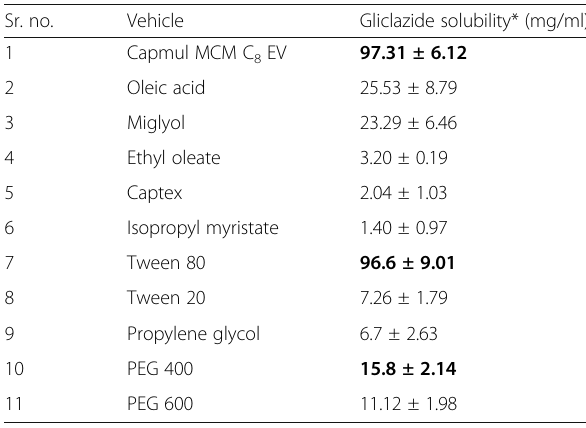
Table 3 Solubility of gliclazide in oil, surfactant, and co- surfactant Sr. no.